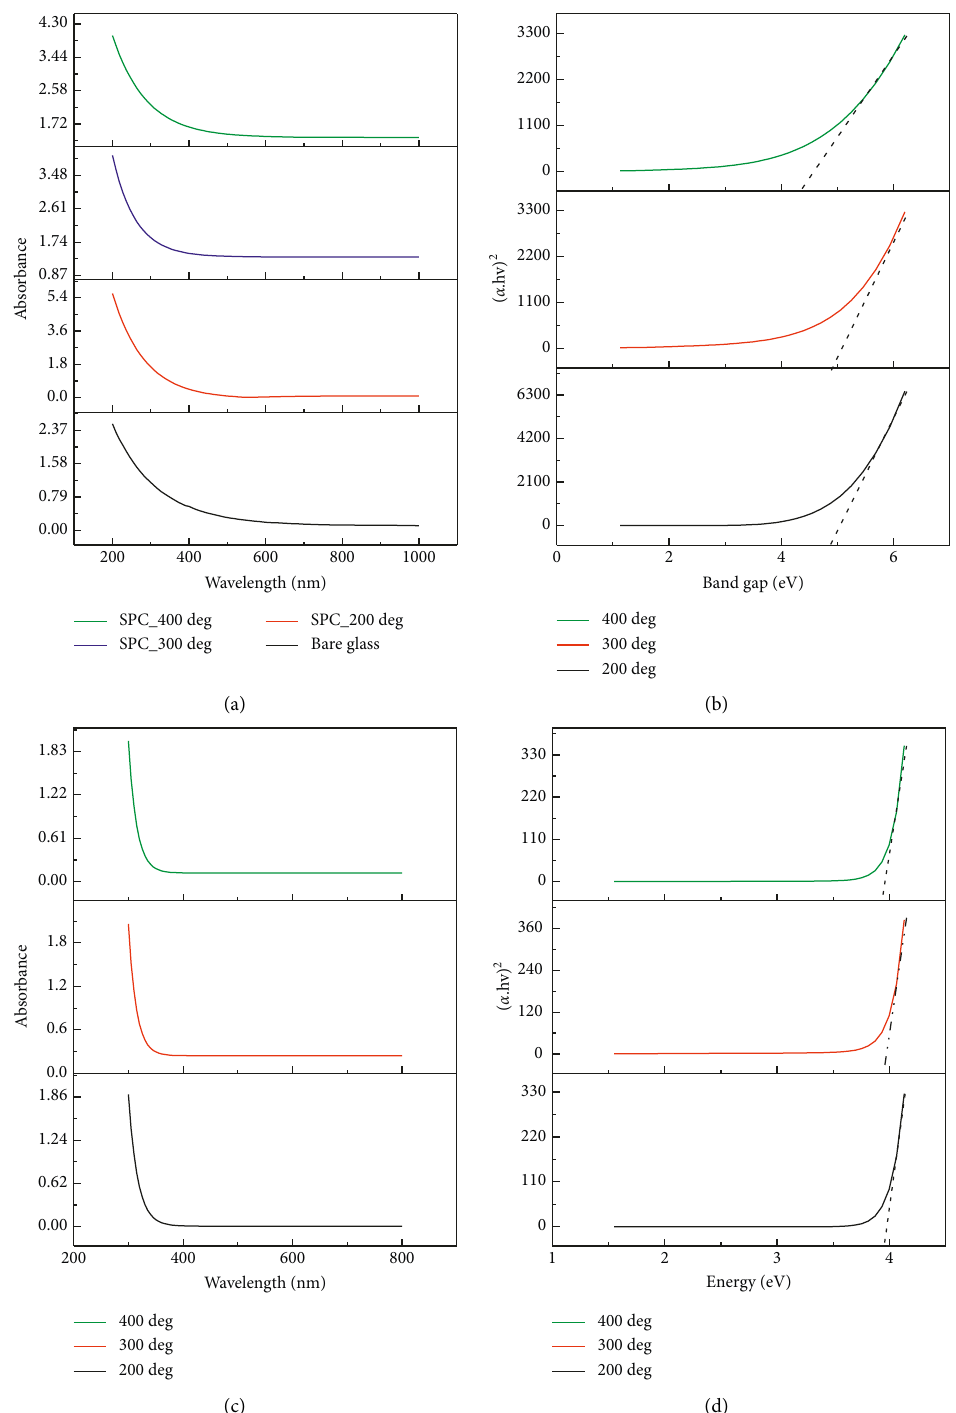
Figure 5: Absorption spectra for NiS produced from spin-coating (a) and solventless (c) methods and stacked Tauc plots showing bandgap energies of NiS from the spin-coating (b) and solventless (d) methods at 200 ° C, 300 ° C, and 400 °